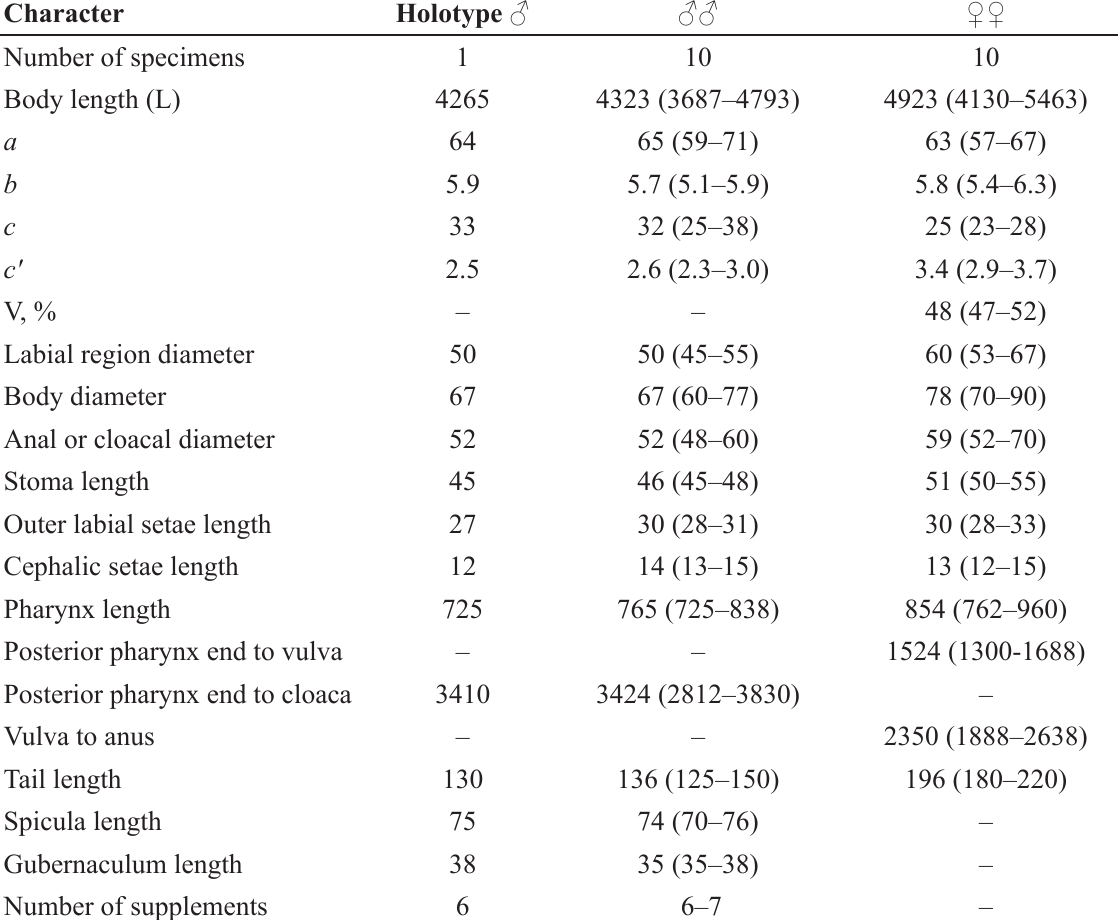
Table 1. Measurements (in µm) of Paratrilobus tankhoyensis sp. nov., presented as mean and range.